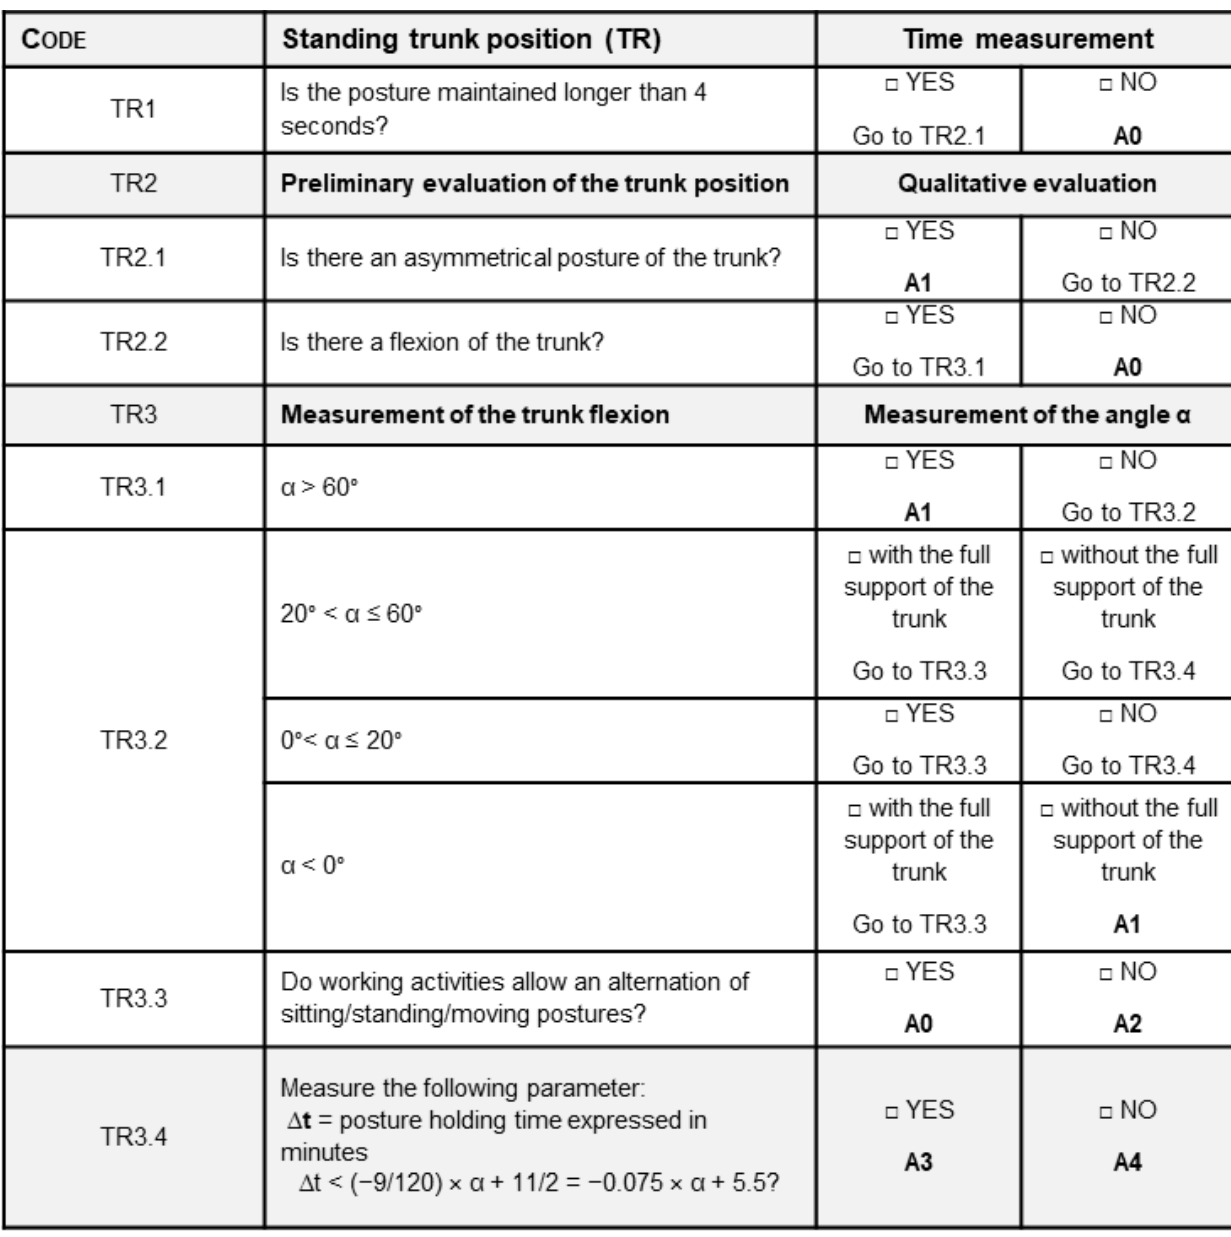
Figure 3. Excerpt of the checklist for the ergonomic risk assessment of the trunk in a standing position, where: A0 stands for “acceptable”; A1 means “not recommended—workstation redesign”; A2 stands for “not recommended—workflow redesign”; A3 means “not recommended—need for recovery time”; A4 means “not recommended—reduction of holding time”.